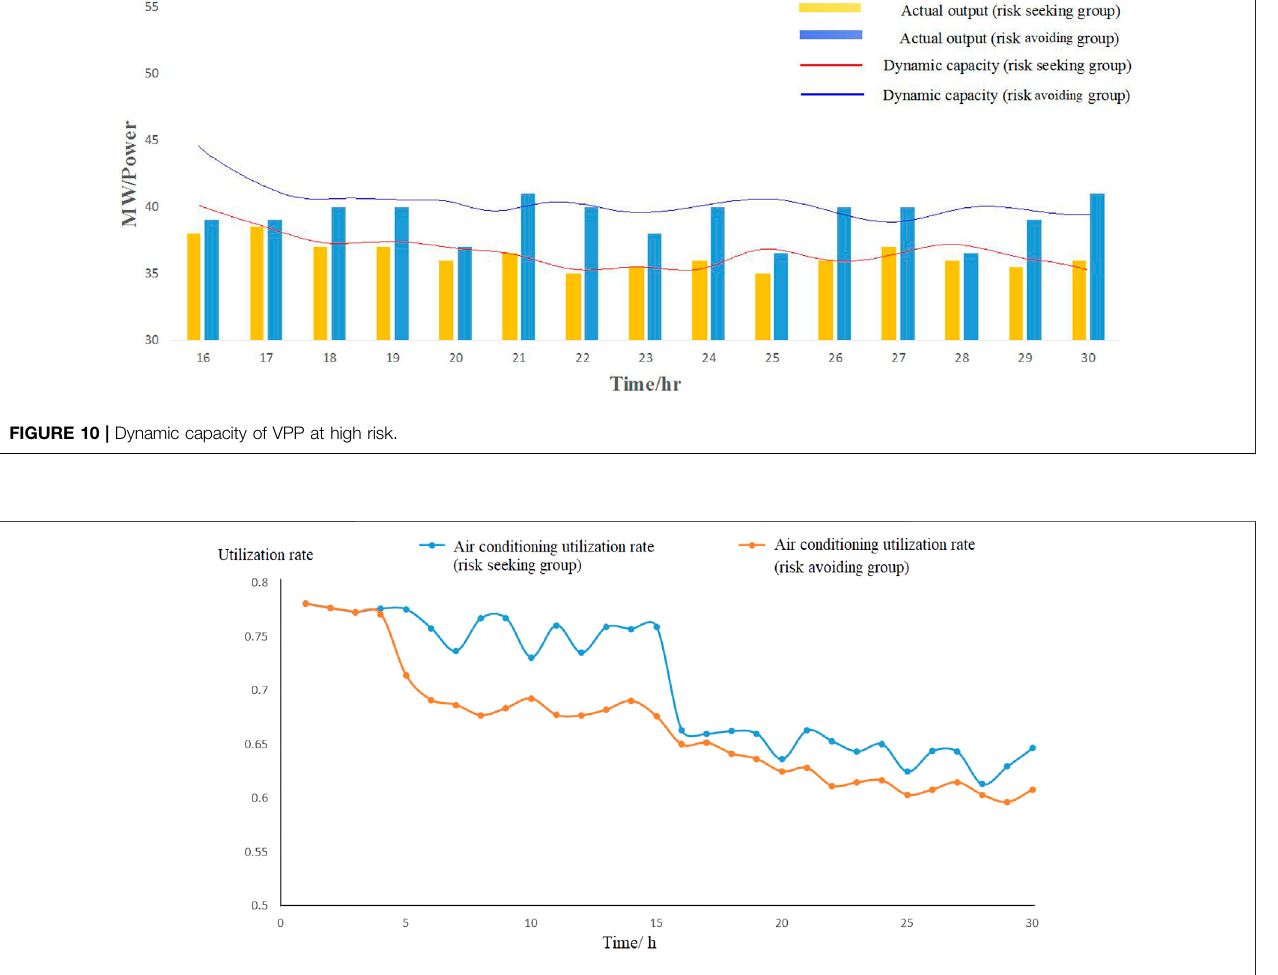
FIGURE 11 | Utilization rate of central air conditioning of different risk preference.